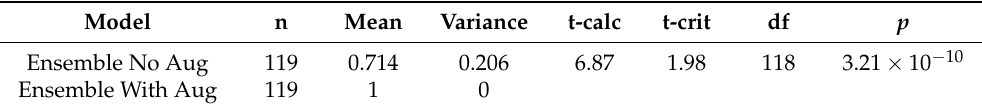
Table 5. Paired t -test Results Comparing Accuracy of Ensemble without Augmentation vs. Ensemble with